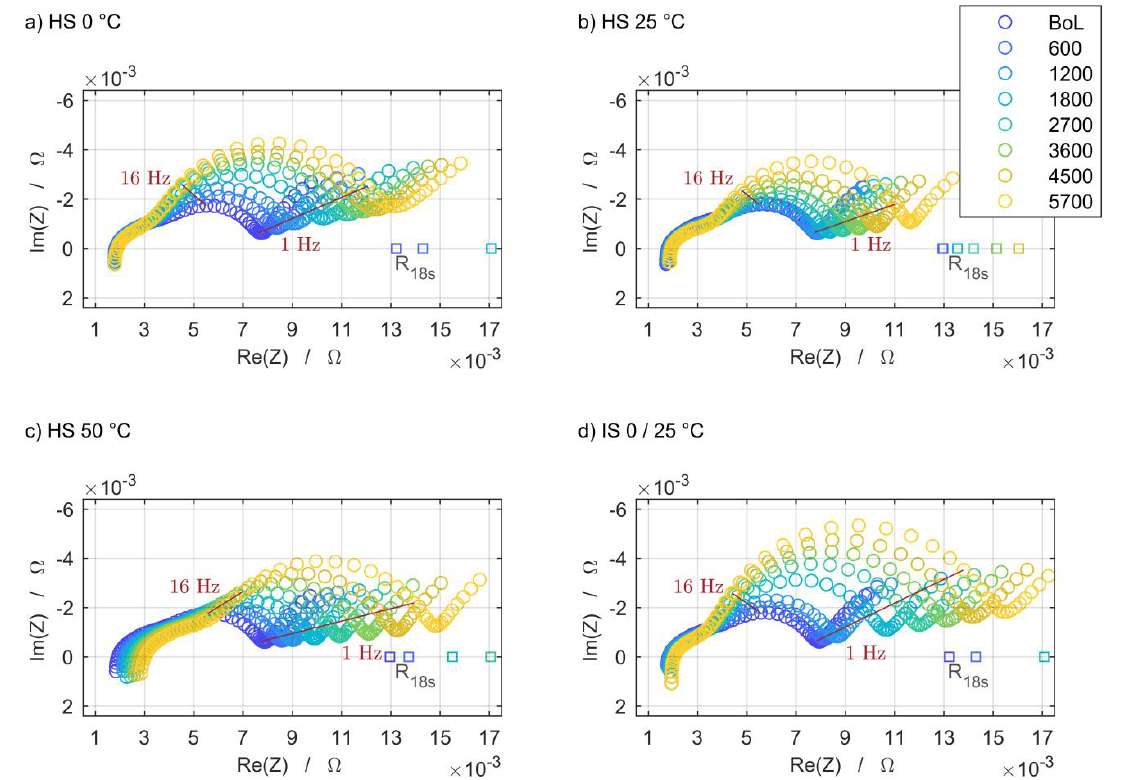
Figure 8. The electrochemical impedance degradation and current pulse resistance increase at the three base temperatures of the homogeneous steady setup is shown in ( a – c ). The influence of the steady thermal gradient in the case of IS 0/25 °C is shown in ( d ).